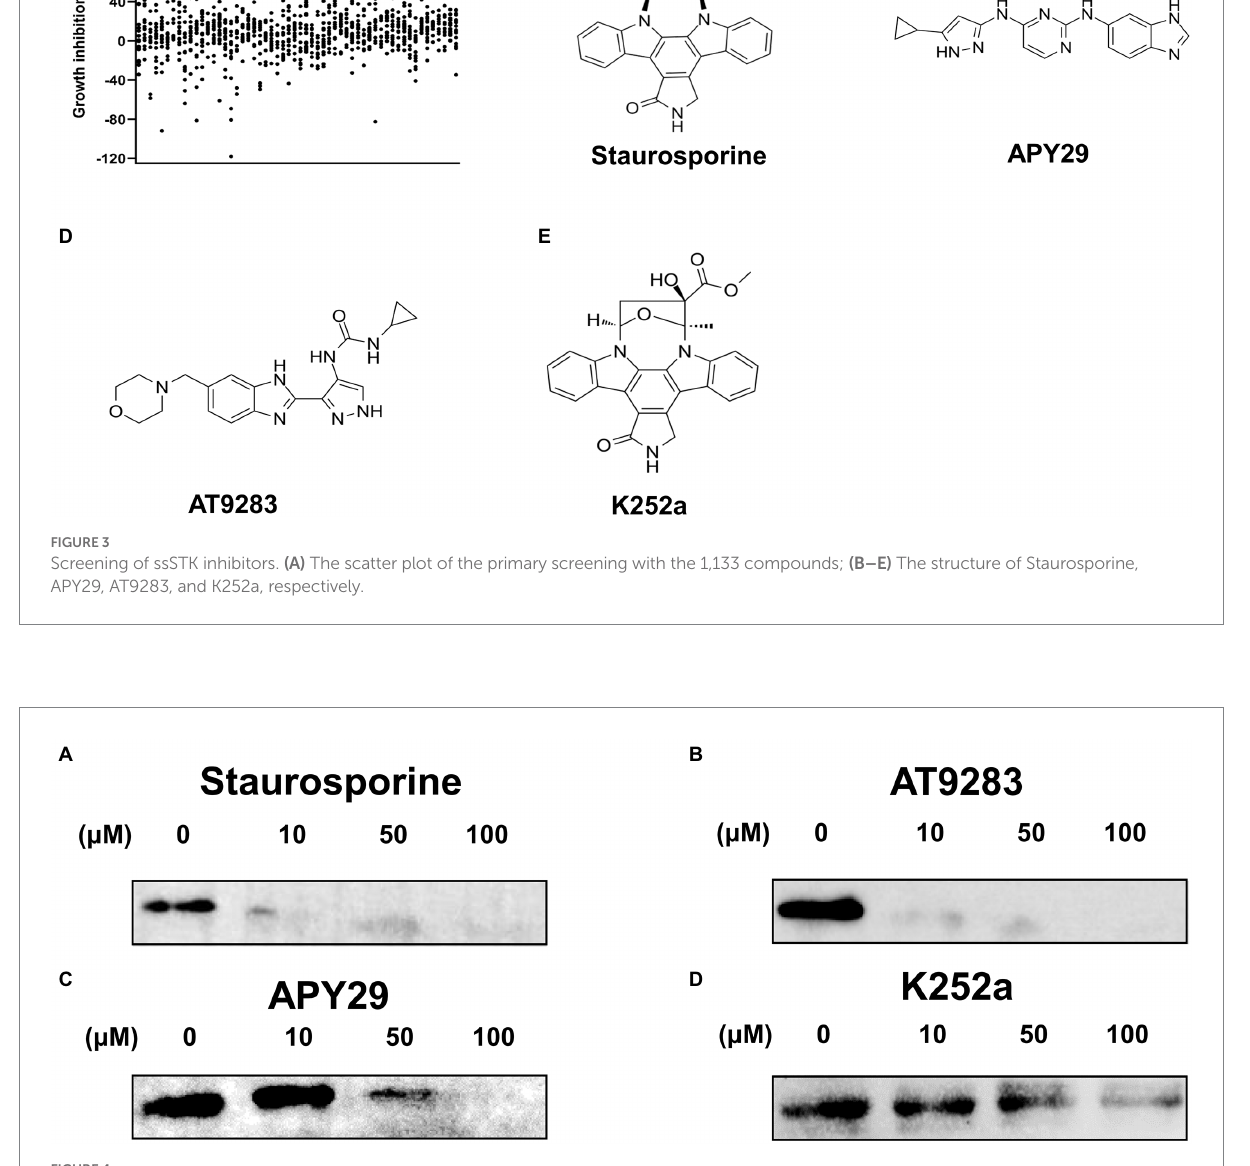
FIGURE 4 Autophosphorylation assay. Inhibitors including Staurosporine (A) , AT9283 (B) , APY29 (C) , and K252a (D) at 100, 50, 10, 0 μ M, and ssSTK were co- incubated at 37 ° C for 30 min, respectively. Next, the samples were boiled in SDS loading buffer and were detected for the autophosphorylation of ssSTK by western blotting using anti-P-Threonine mouse monoclonal antibody. The experiments were carried out two times independently under the same